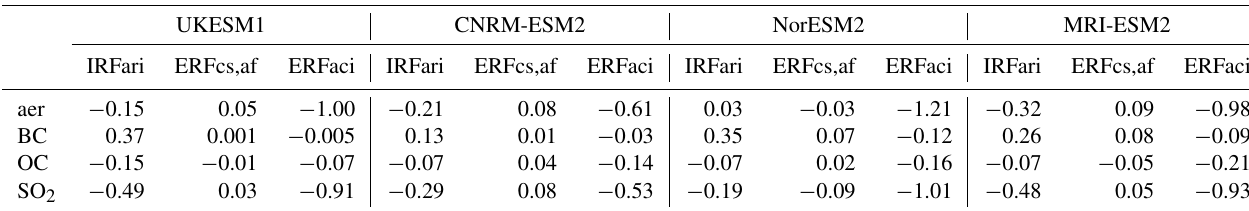
Table 3. Results for IRFari, ERFaci and ERFcs,af for aerosol experiments from several models.